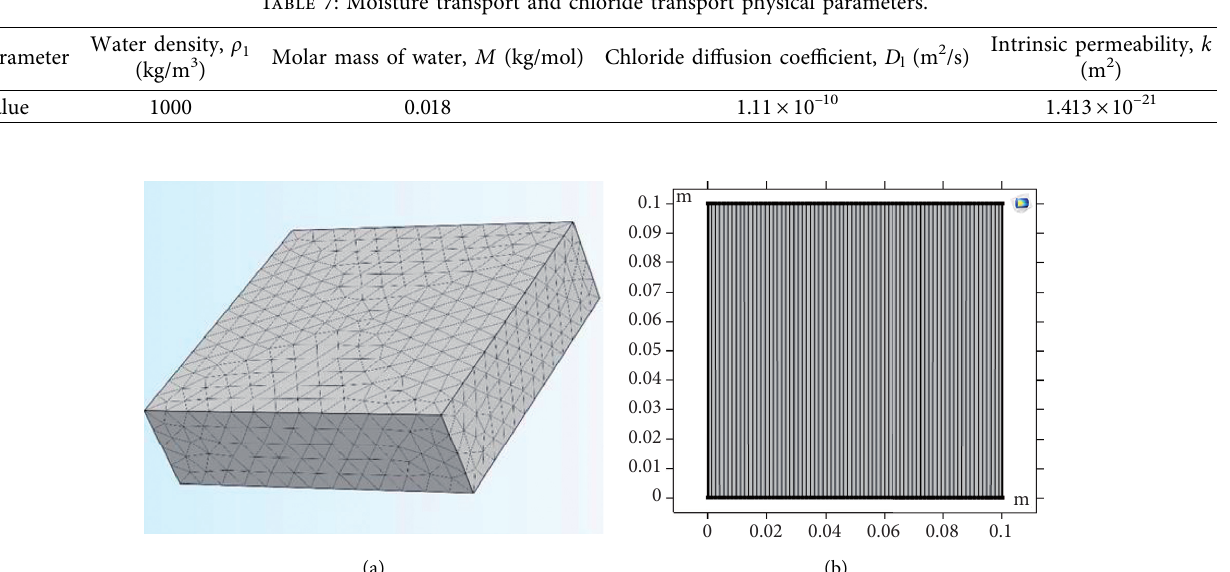
Table 7: Moisture transport and chloride transport physical parameters.